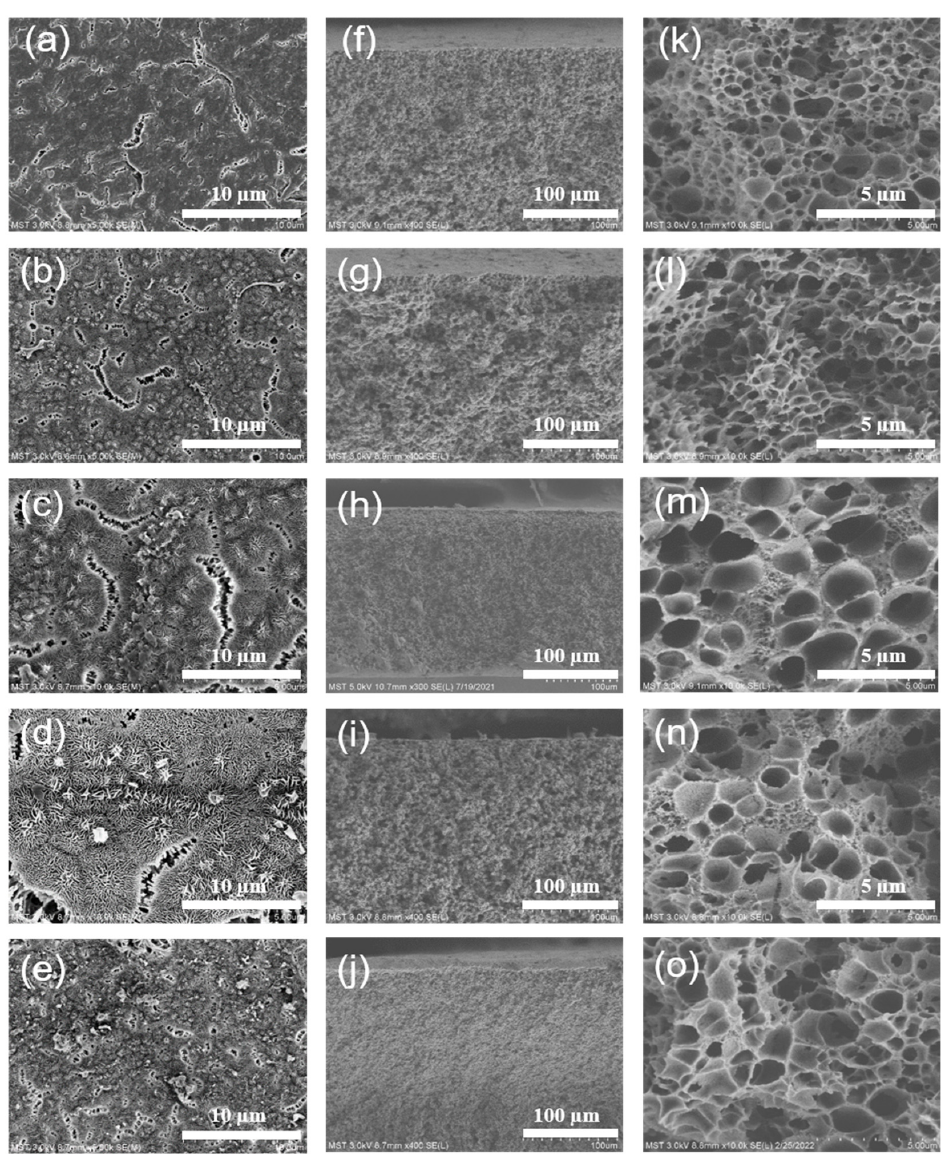
Figure 10. Surface SEM images of ECTFE membranes prepared at different cooling rate: ( a ) 0 °C; ( b ) 15 °C; ( c ) 30 °C; ( d ) 45 °C; ( e ) 60 °C. Cross section SEM images of ECTFE membranes prepared at different cooling rate: ( f ), ( k ) 0 °C; ( g ), ( l ) 15 °C; ( h ), ( m ) 30 °C; ( i ), ( n ) 45 °C; ( j ), ( o ) 60 °C.3.2.2. Mean Pore